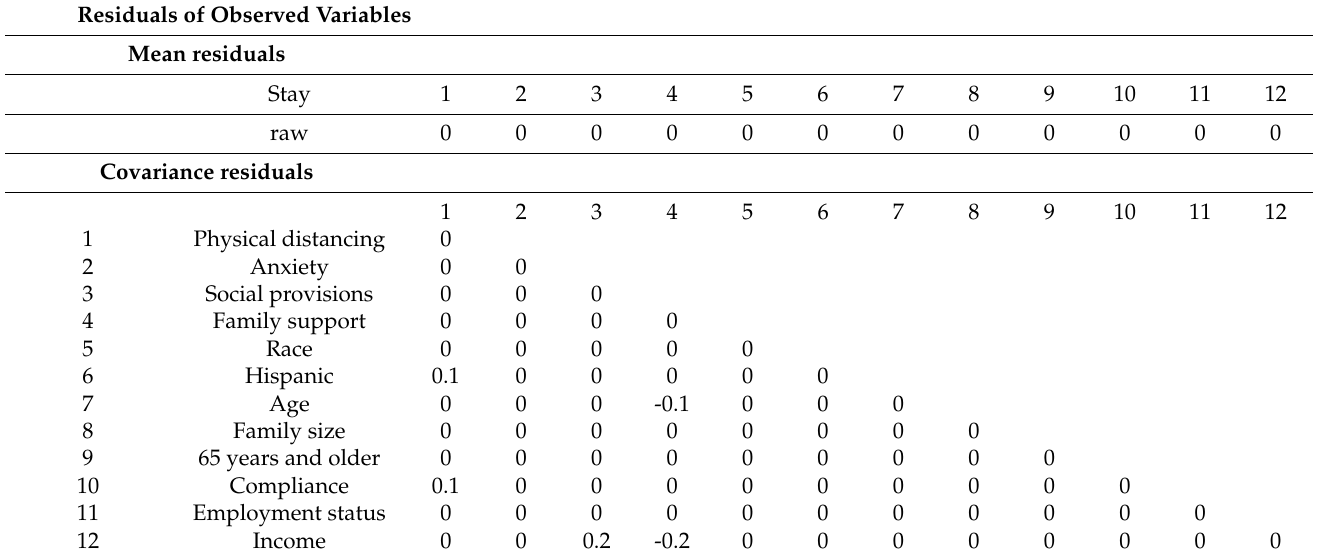
Table A3. Residuals of observed variables.